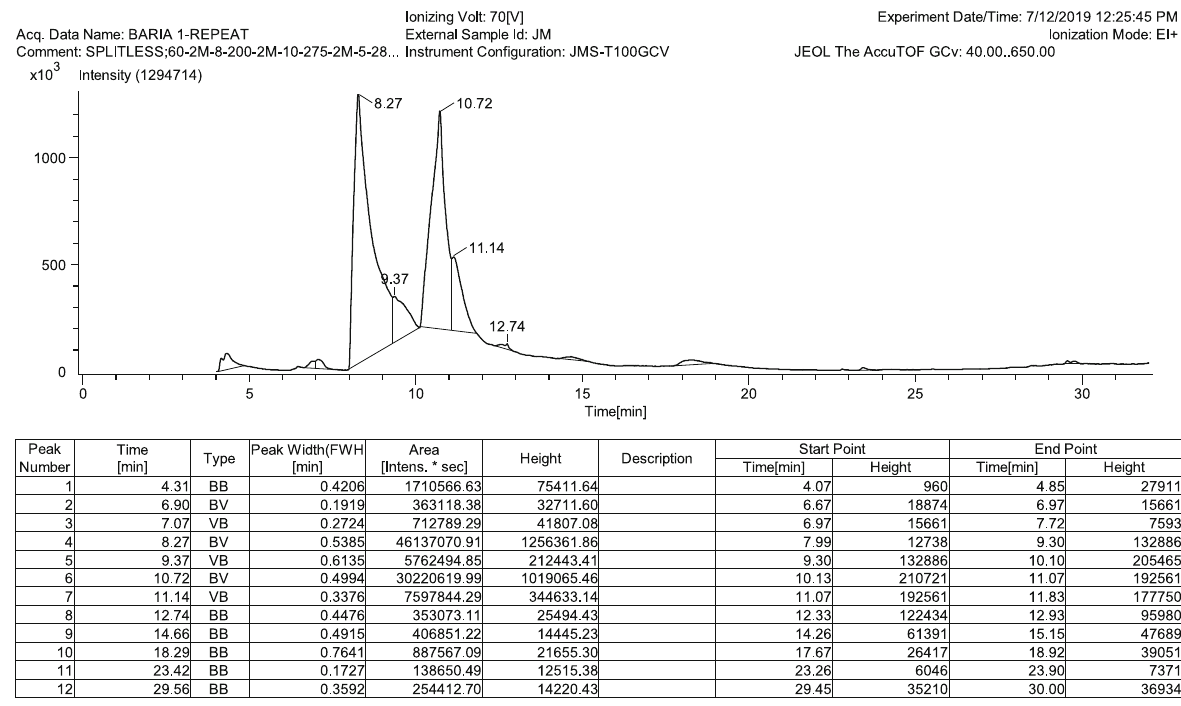
Fig. 1 GCMS chromatogram of methanol extract of fermented Syzygium cumini